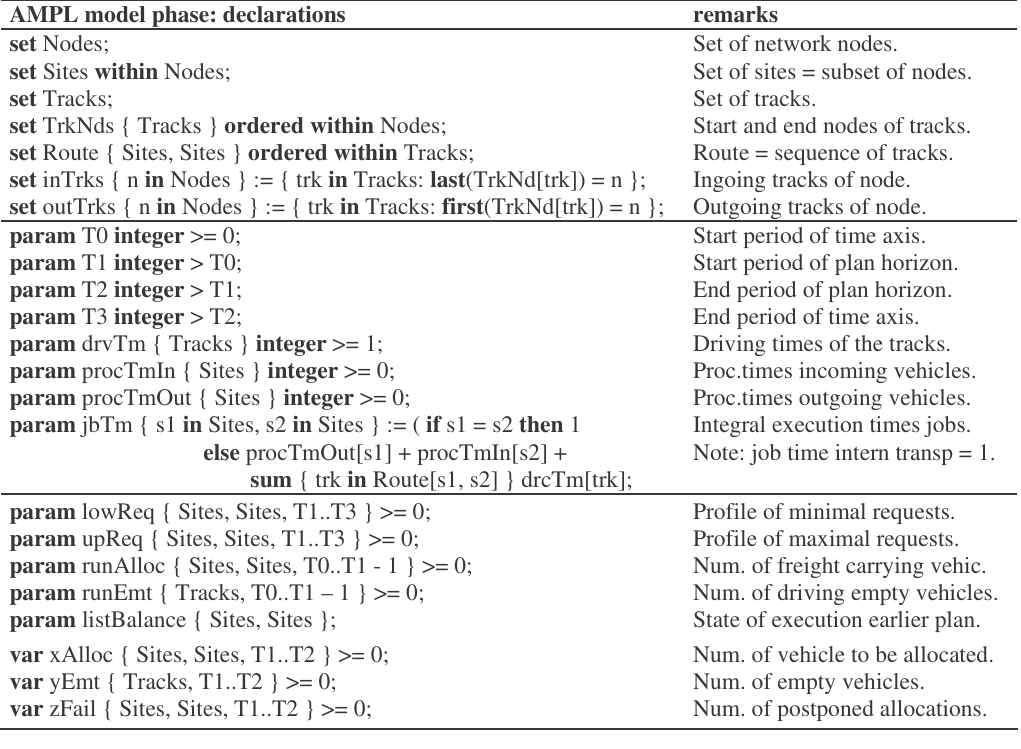
Table 2. Declaration of the AMPL model (without capacity